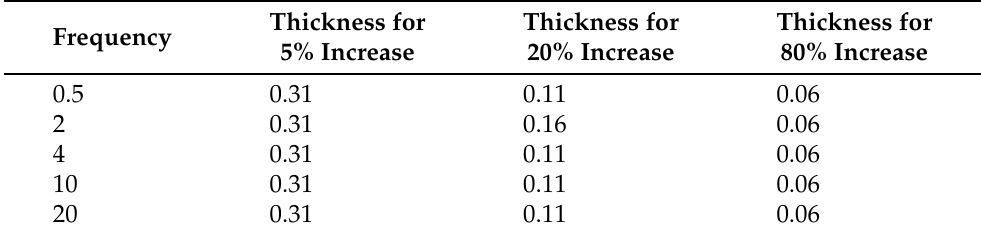
Table 7. Retrieved relative permittivity change of skin–olive oil double-layered configurations